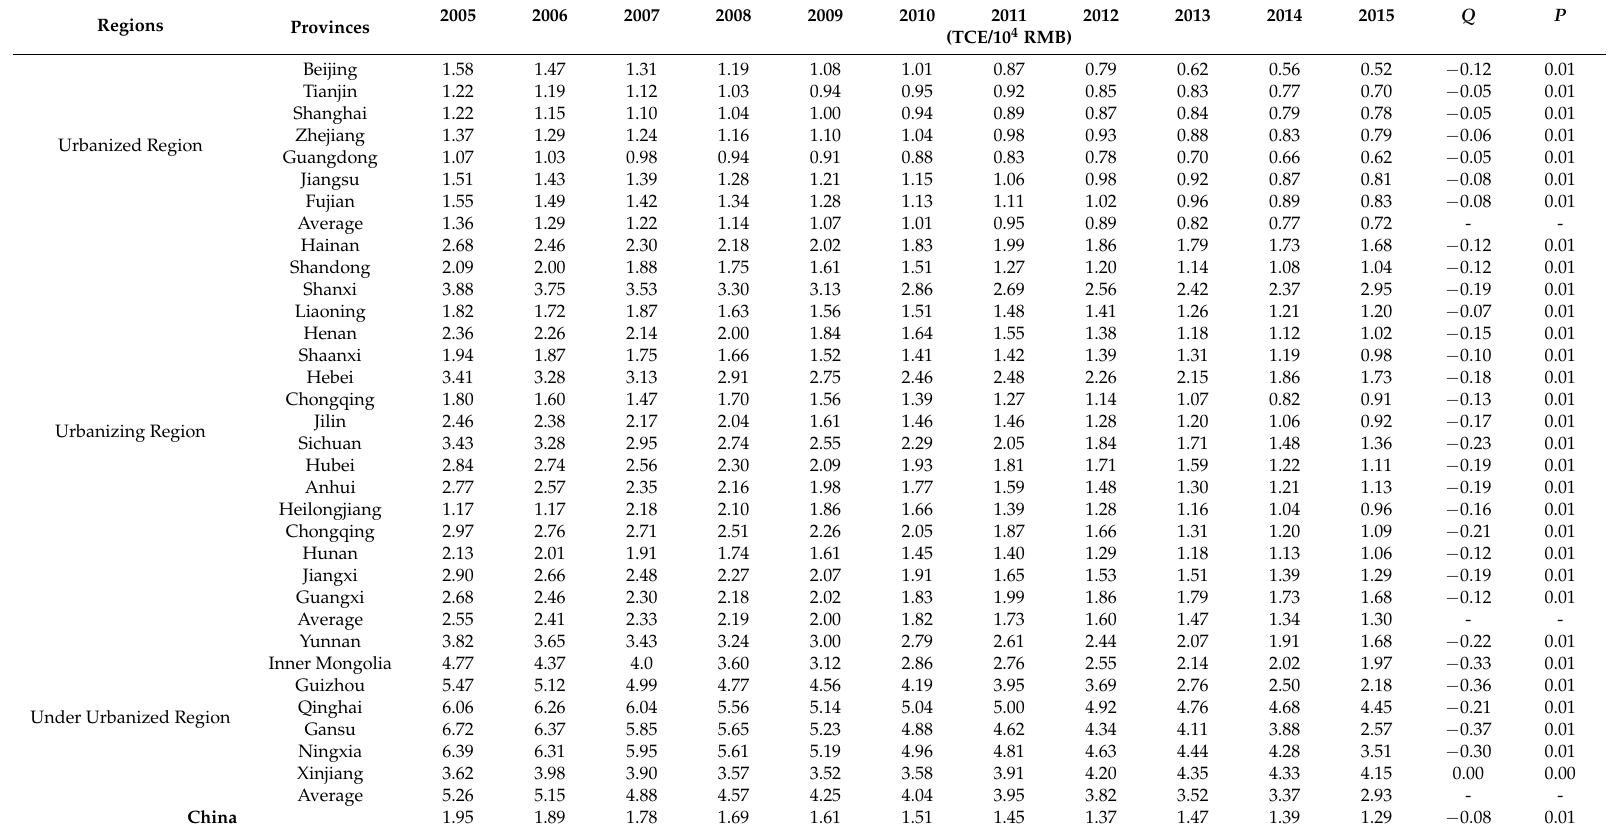
Table A6. China’s energy consumption intensity (ECI), Sen’s slope (Q), and significance level (P) of secondary industry (SI) at provincial and national levels between 2005 and 2015. Regions Provinces